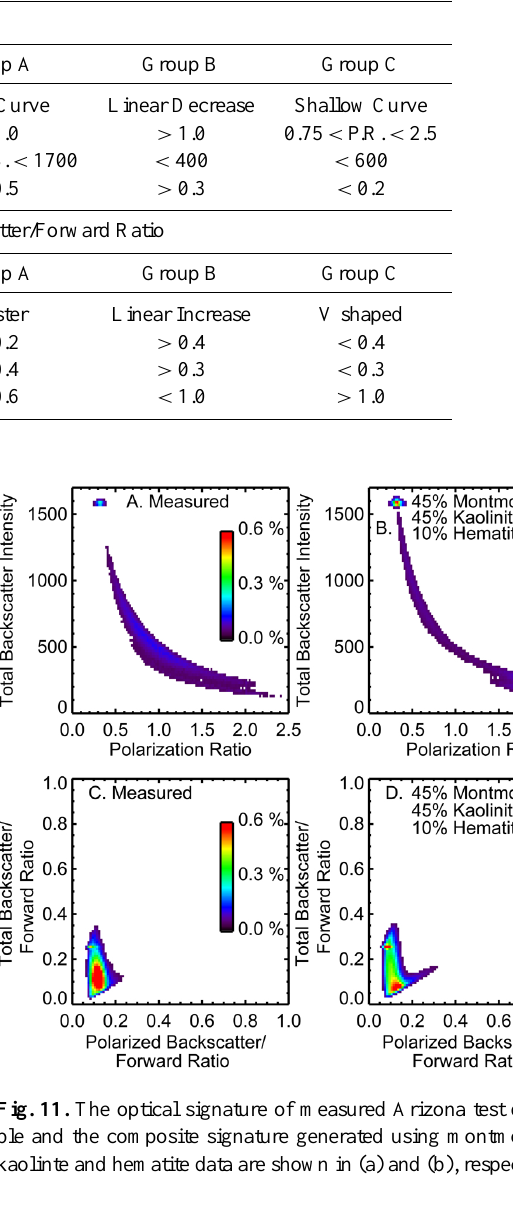
the composite signature has a narrower distribution in total backscatter intensity at a polarization ratio of ∼